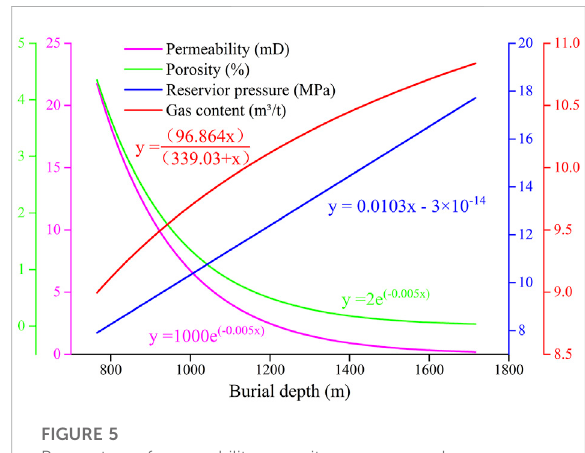
FIGURE 5 Parameters of permeability, porosity, pressure, and gas content in the ASIM and ISIM